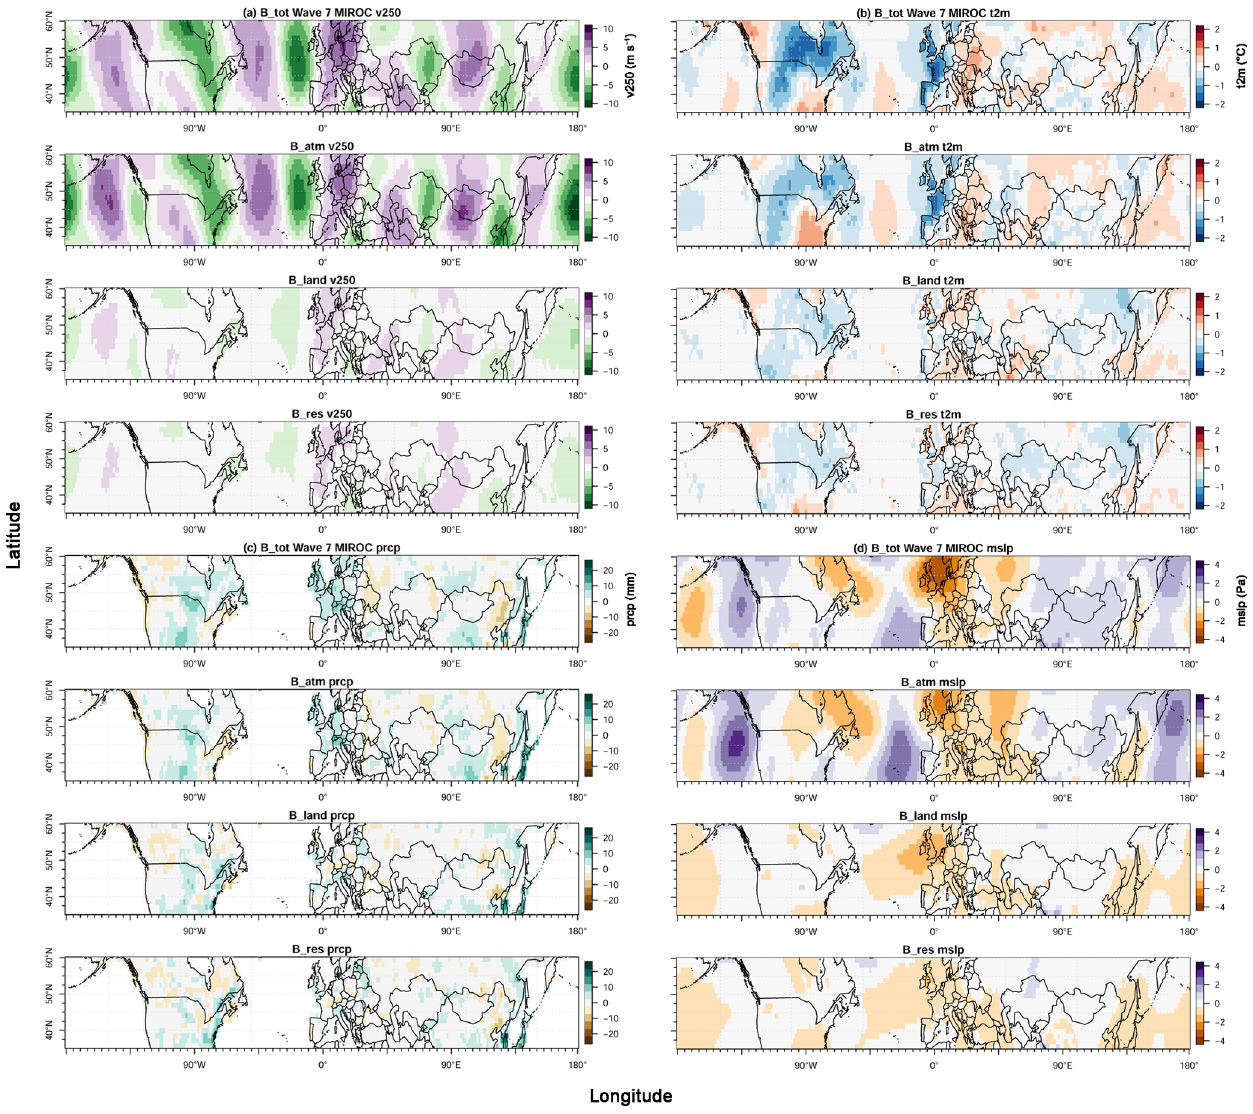
Figure B9. Bias plots for high-amplitude wave-7 events and episodes in different experiments for MIROC. Total bias (B_tot), atmospheric bias (B_atm), land–atmosphere interaction bias (B_land), and residual bias (B_res) for meridional wind velocity at 250hPa (a) , surface temperature (b) , precipitation (c) , and sea level pressure (d)